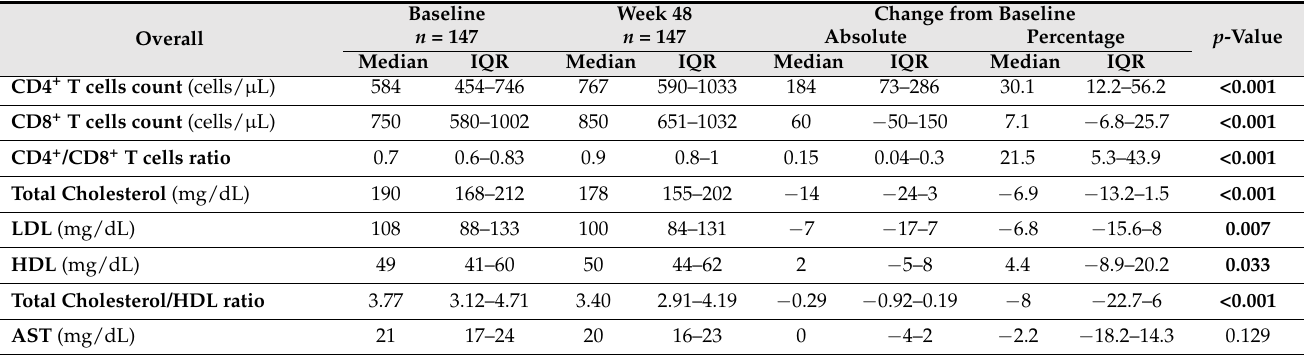
Table 2. Longitudinal analysis showing immunologic and metabolic profile changes from baseline